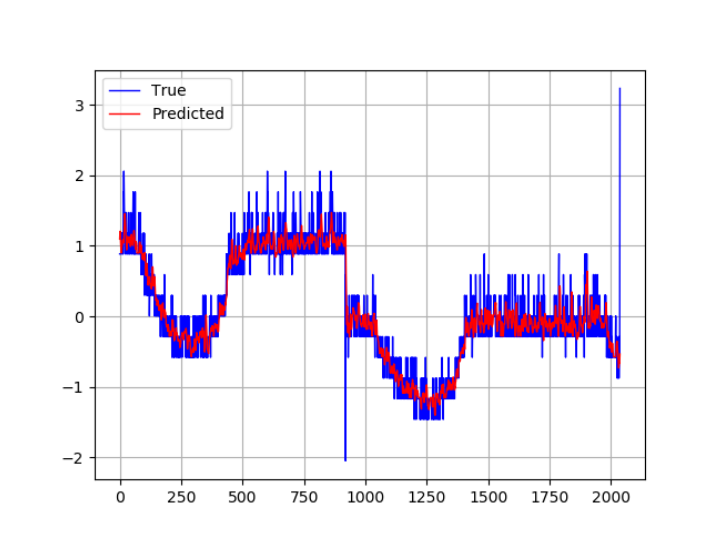
Figure 7. Example of the ARP algorithm result